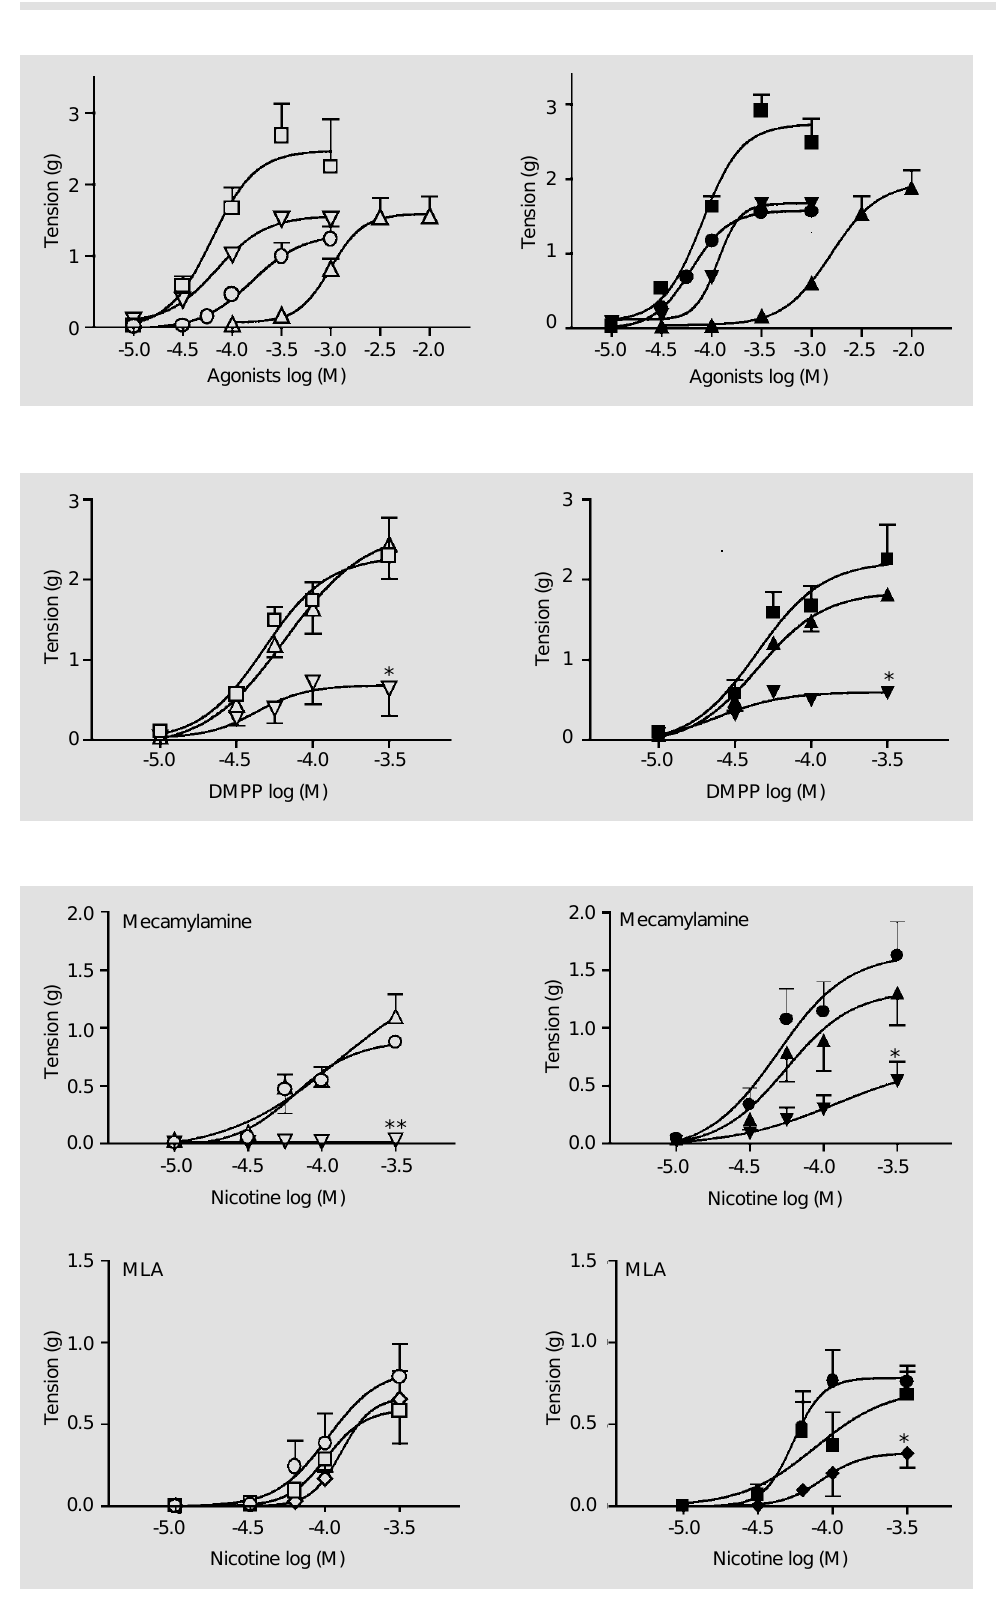
amine (inverted triangles, N = 6), 10 nM MLA (squares, N = 6), and 100 nM MLA (lozenges, N = 6). Data are reported as mean ± SEM. Note that 10 nM meca- mylamine completely blocked the nicotine-induced contraction in organs obtained at 15:00 h. *P<0.01 and **P<0.001 com- pared to control (ANOVA + Newman Keuls